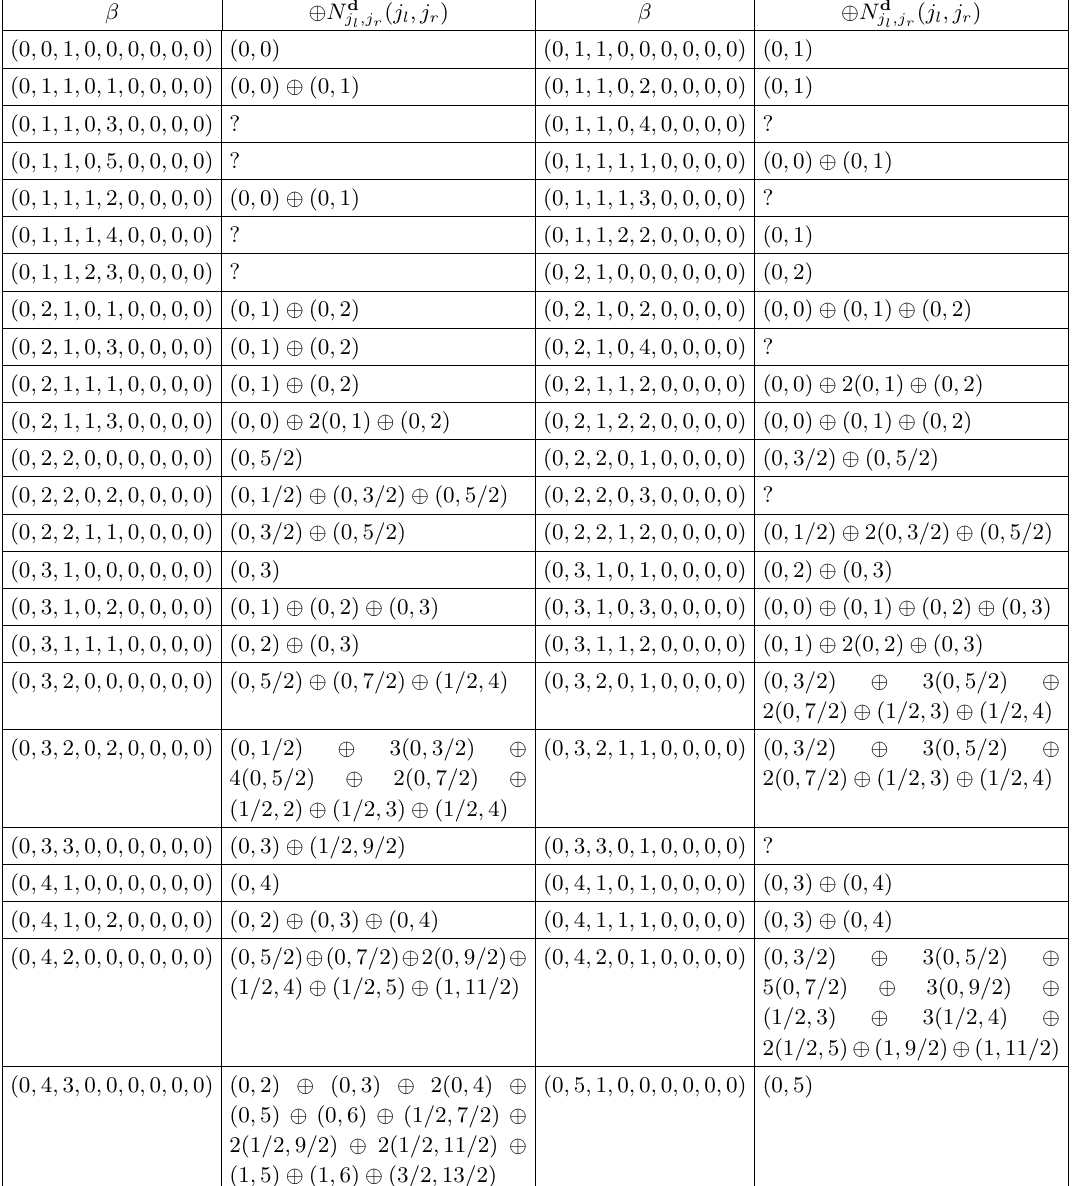
Table 23 . Refined BPS invariants of 6d n = 3 , so (7) model, with su (2) × su (2) masses turned on.